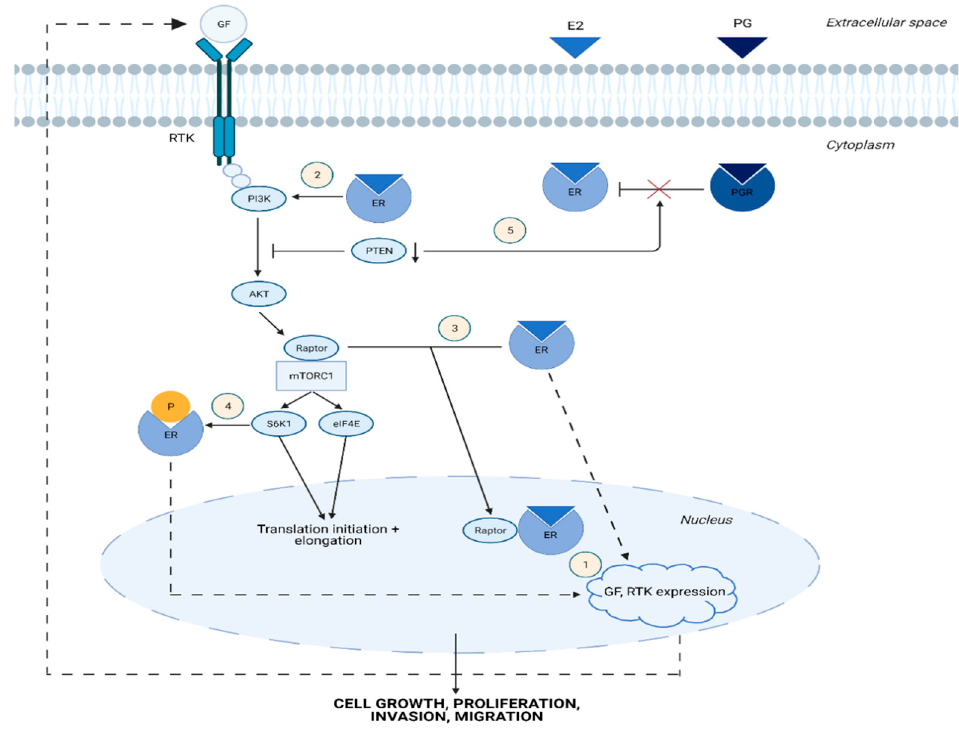
Figure 1. Cross-talk between estrogen and PI3K/AKT/mTOR signaling pathway (1) ERs induce the expression of upstream regulators of the PI3K/AKT/mTOR pathway. (2) Activated ER directly binds to PI3K and promotes its phosphorylation. (3) Estrogen-bound ER attaches to Raptor, causing its translocation to the nucleus. (4) mTORC1 leads to ER phosphorylation and activation via S6K1. (5) Low PTEN expression and thus aberrant PI3K/AKT/mTOR pathway activation may lead to pro- gesterone resistance in the endometrium. E2, estradiol; PG, progesterone; ER, estrogen receptor; PGR, progesterone receptor; GF, growth factor; RTK, receptor tyrosine kinase; PI3K, phosphatidylinositol-3- kinase; PTEN, phosphatase and tensin homolog; AKT, protein kinase B; Raptor, regulatory-associated protein of mTOR; mTORC1, mammalian target of rapamycin complex 1; S6K1, p70S6 Kinase 1, eIF4E, eukaryotic translation initiation factor 4E. Graphic created with